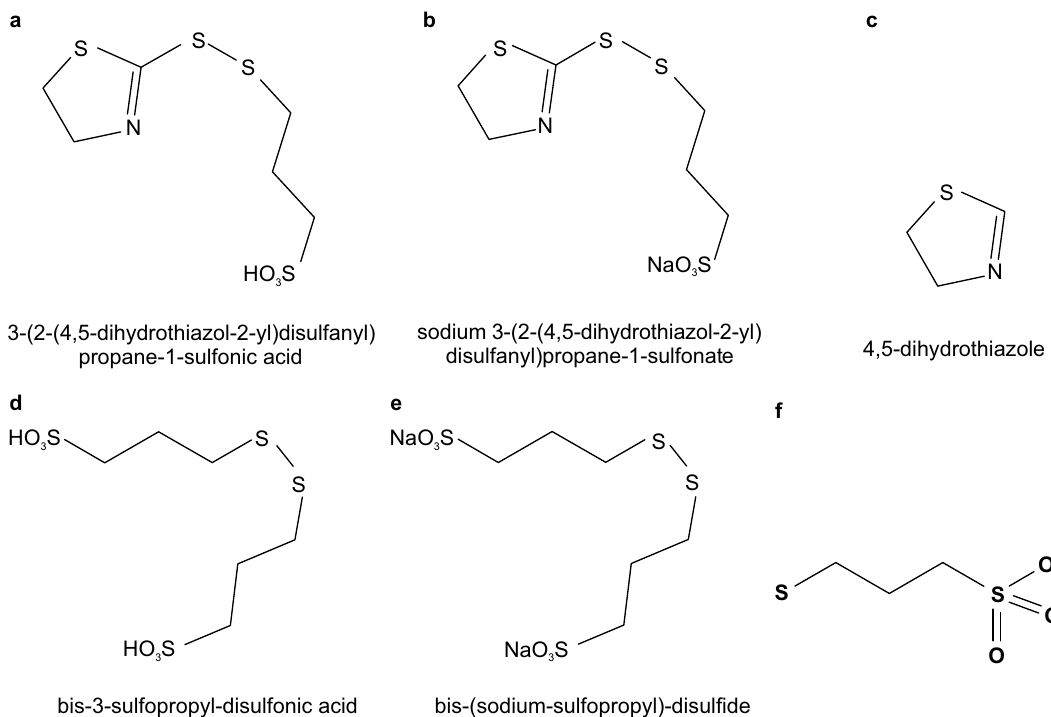
Figure 10. Chemical formulas of SH110 and SPS used in this study. ( a ) SH110; acidic form, ( b ) SH110; sodium salt, ( c ) 4,5-dihydrothiazole (DHT), ( d ) SPS; acidic form, ( e ) SPS; sodium salt, and ( f ) 3-mercaptopropane sulfonate